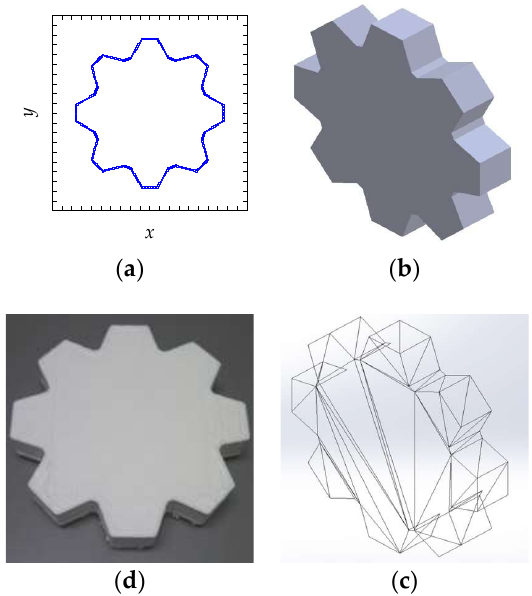
Figure 5. PCAM of gear model using parametric-equation-based approach. ( a ) Point-cloud of a gear created by the parametric equations of some piecewise lines; ( b ) CAD modeling of the gear; ( c ) Triangulation modeling of the gear; ( d ) Additive manufacturing (3D printing).